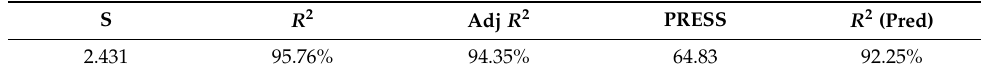
Table 7. Predictive ability and fit of Stay in the office PLSR model.